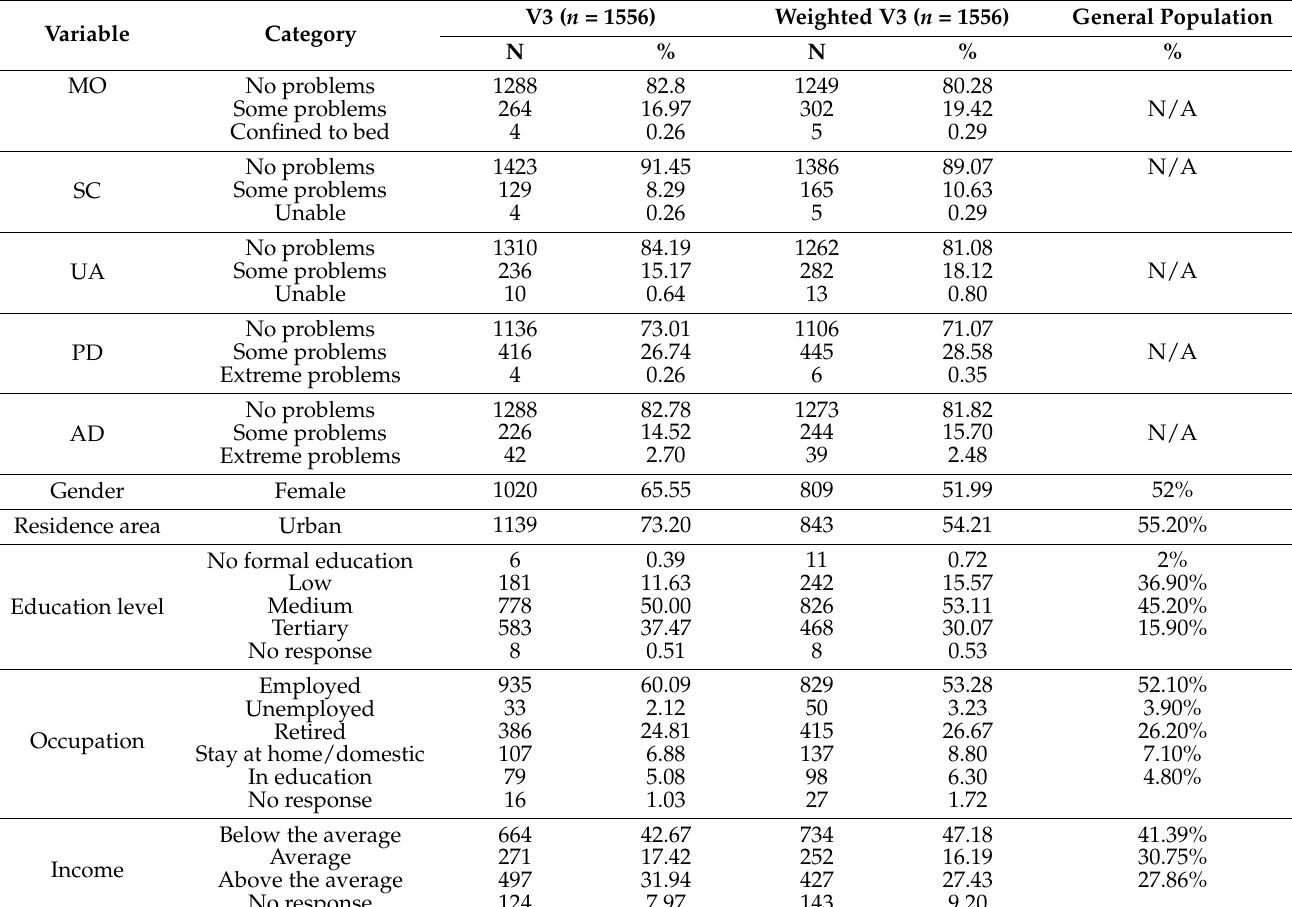
Table 2. Respondents’ characteristics—categorical variables, dataset